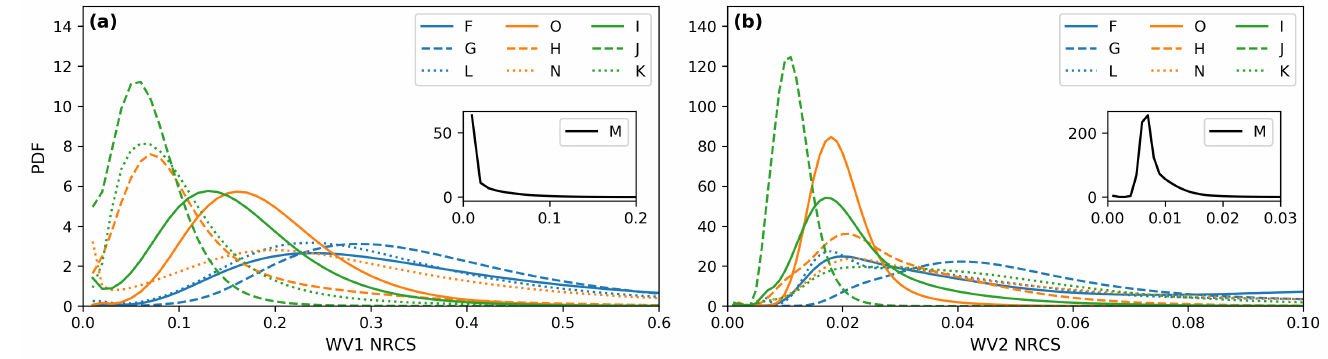
Figure 3. NRCS PDFs of the ten labeled classes for ( a ) WV1 and ( b )